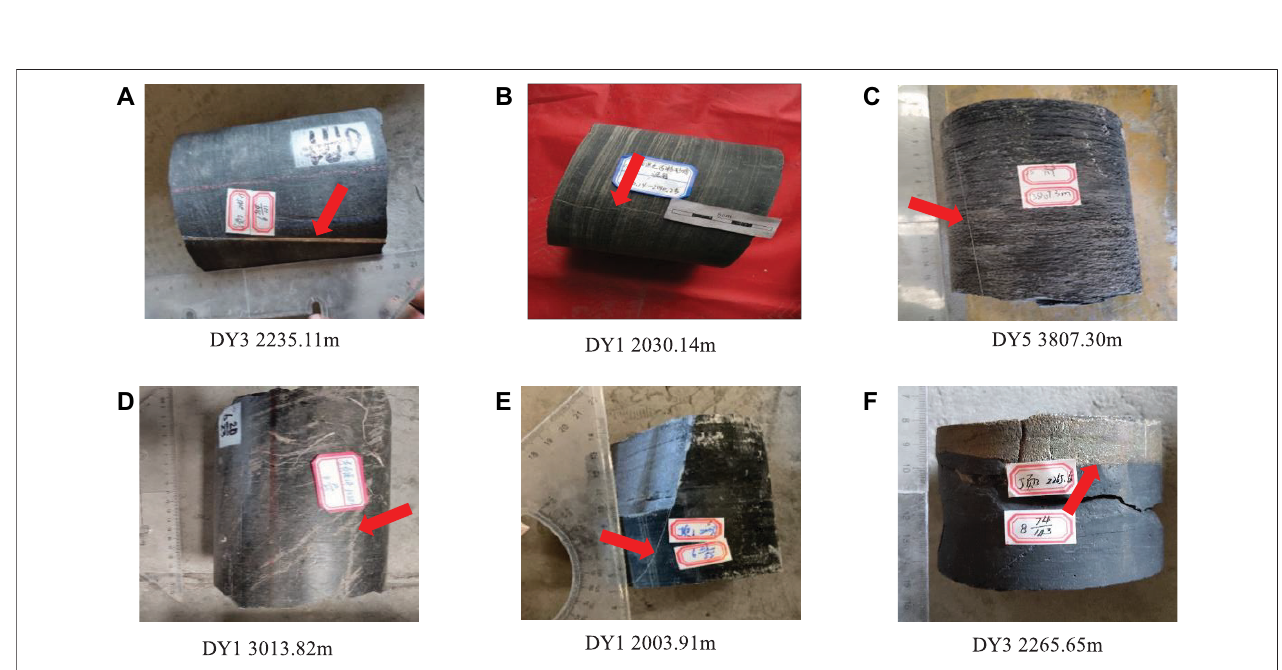
FIGURE 3 | Characteristics of shale core fracture in the Longmaxi formation of Dingshan area. (A) DY3 2235.11 m. (B) DY1 2030.14 m. (D) DY1 3013.82 m. (E) DY1 2003.91 m. (F) DY3 2265.25 m.